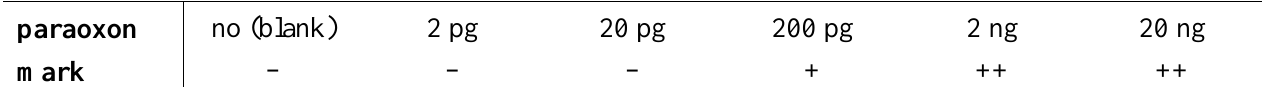
Table 2. Performance of AChE based biosensor for real time assay of organophosphate paraoxon. The three symbols are used in this table as mark for the outputting value: – (no significant detection), + (decrease of current above limit of detection: S/N >3), ++ (decrease of current above limit of quantification S/N>10) when current measured one minute after paraoxon